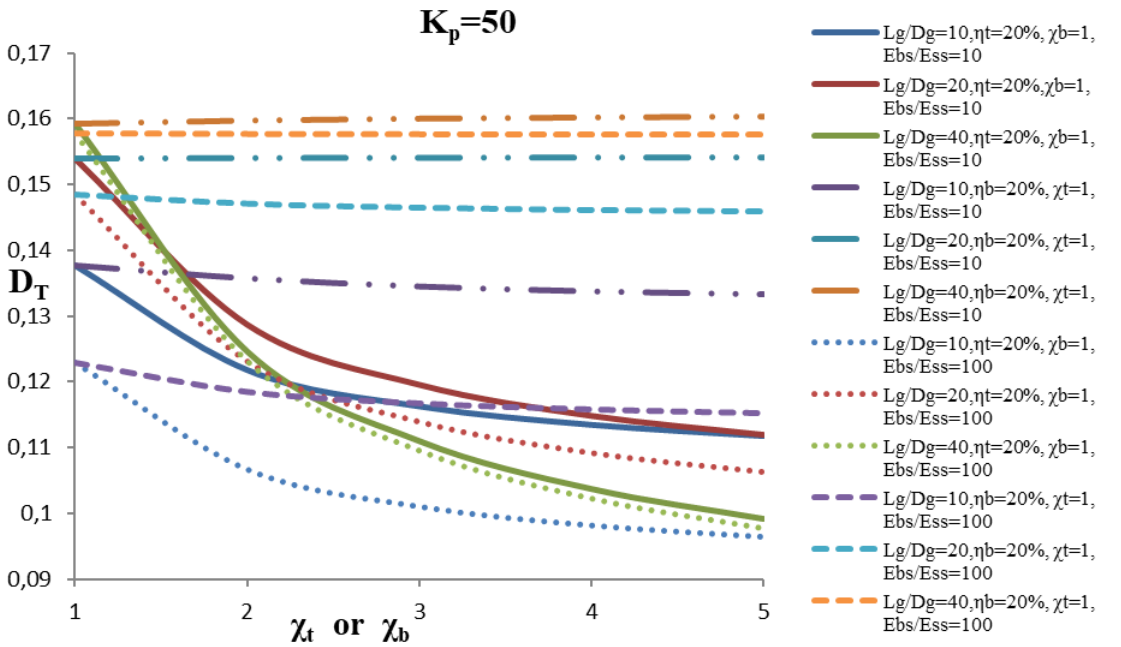
, with strengthening factor for the top, χ T /D ; PLST of GP, η ; PLSB of GP, η ; and relative stiffness of bearing stratum, g g t b